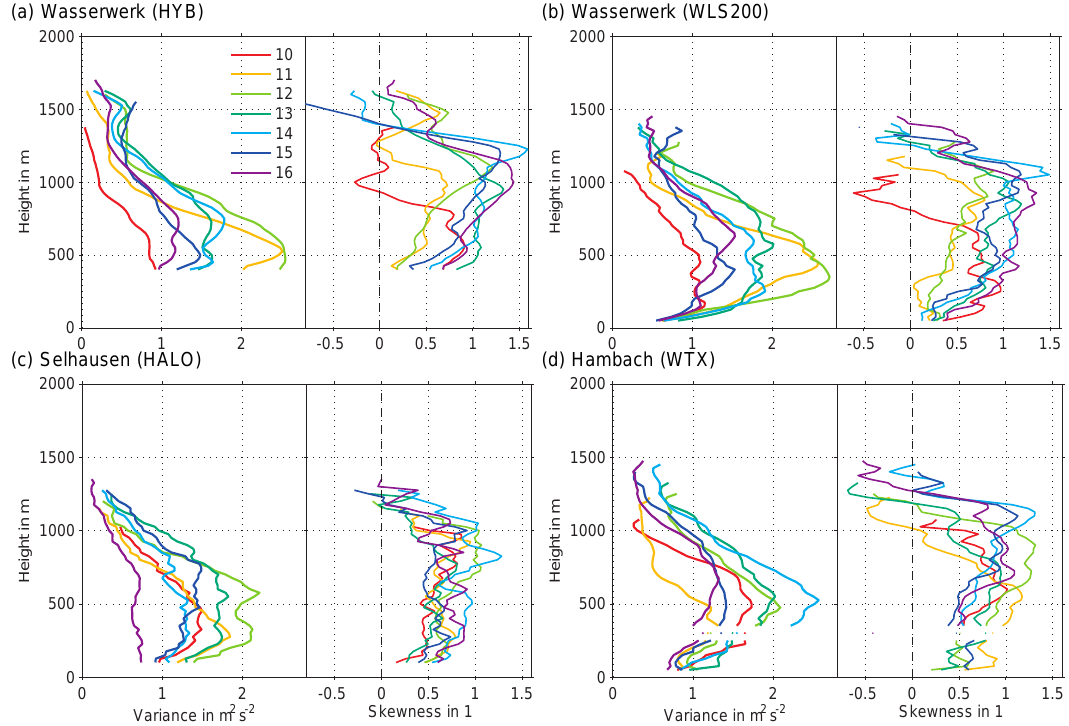
Figure 6. Vertical profiles of hourly vertical velocity variance and skewness from lidar measurements at the three locations for 10:00– 17:00UTC on 20 April 2013; the legend labels in (a) refer to the end in UTC for each averaging period of